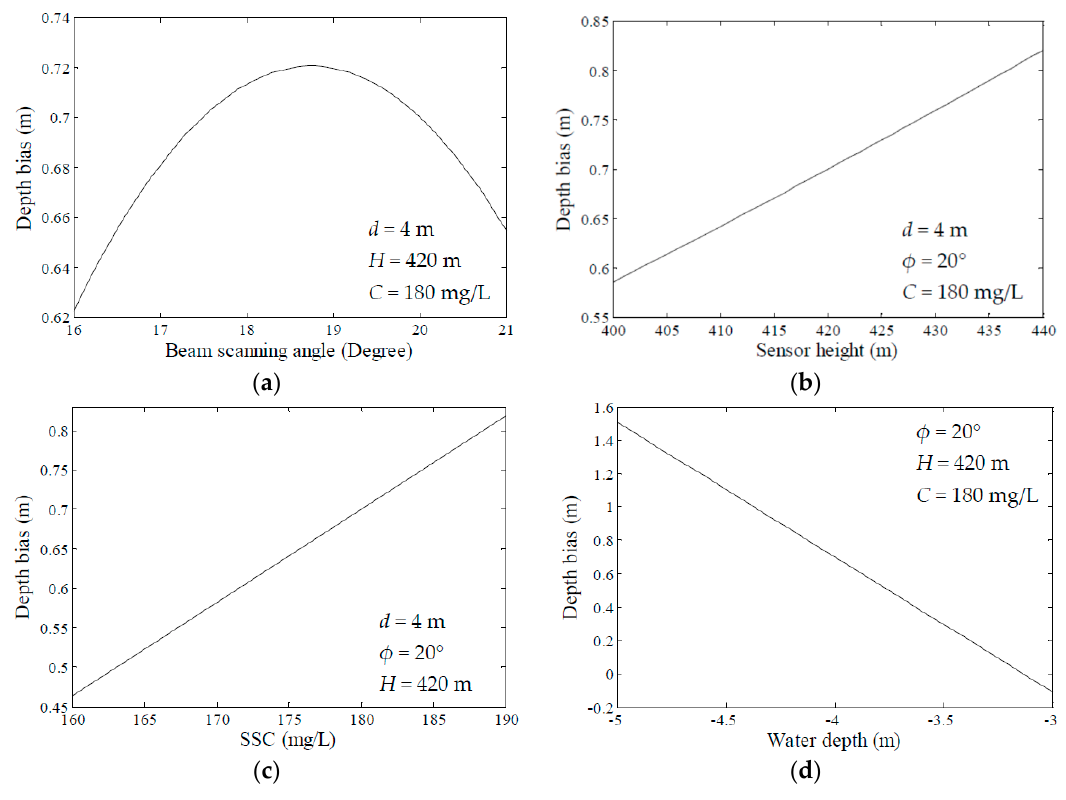
Figure 4. Regression curves of depth biases, ∆ d , varying with ALB measurement and ocean hydrological parameters. ∆ d varying with ( a ) beam scanning angle, ( b ) sensor height, ( c ) SSC, and ( d ) water depth exhibits a parabola, monotonically increases, monotonically increases, and monotonically decreases, respectively.